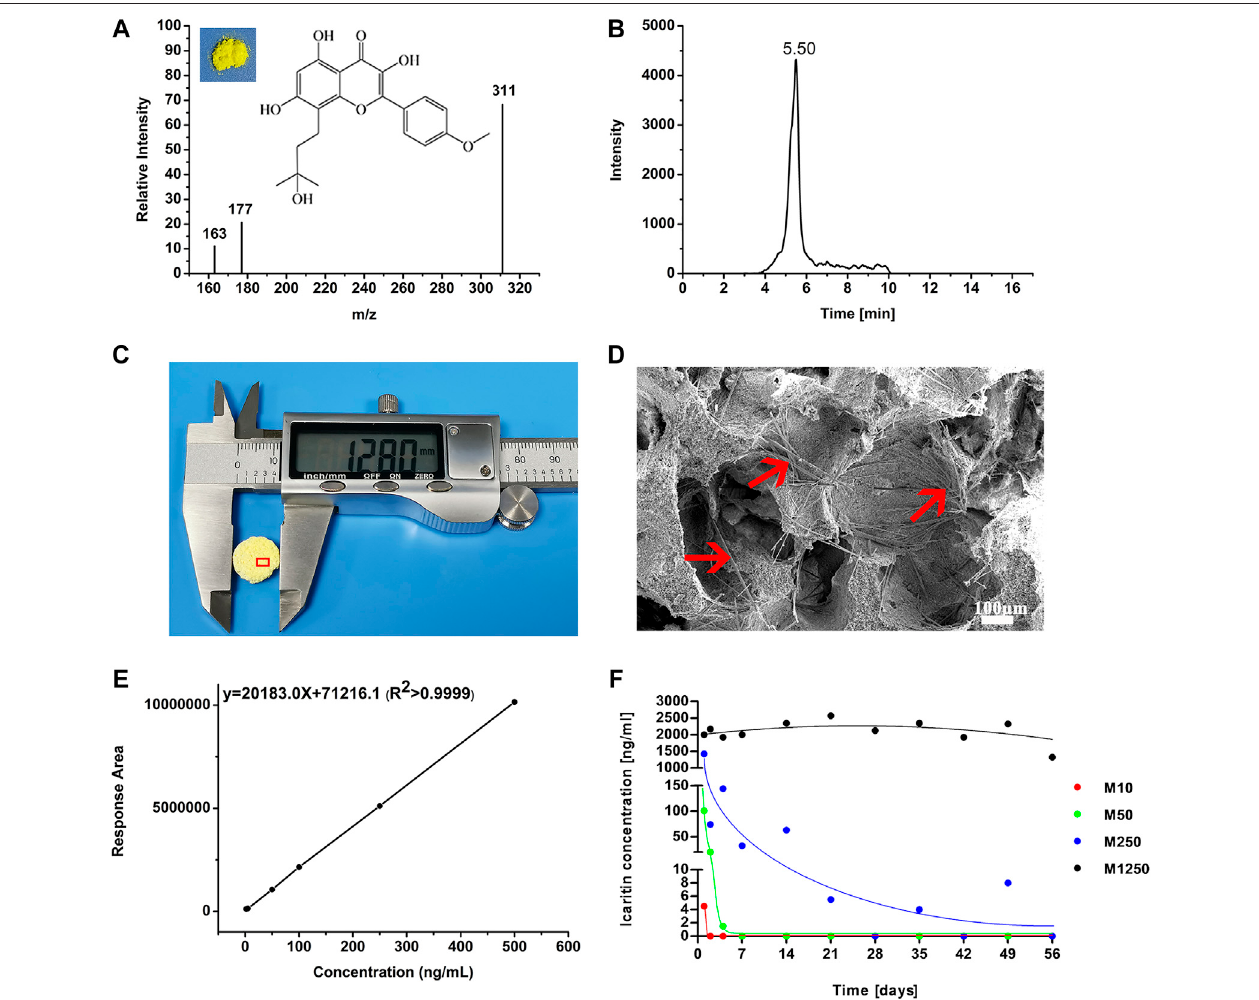
FIGURE 3| Icaritin release and detection. (A) Chemical structure and fullscan product ionofprecursor ion oficaritin (the quanti fi cation ion at m/z 311is generated viathelossofC 4 H 9 Ofromtheprecursorion), (B) HPLC-MS/MStotalionchromatographyoficaritin, (C) 12.8 mmCaPceramicdiscwithicaritin, (D) needle-likeicaritinon the surface of CaP ceramic (red arrow), (E) the icaritin calibration line between the concentrations from 2 to 500 ng/ml in culture medium, and (F) median values of the measured icaritin concentrations in the culture medium plotted against time (please note that the ordinate axis is split into three intervals for a better visualization of the results, which include all the data point measurements from all the materials).